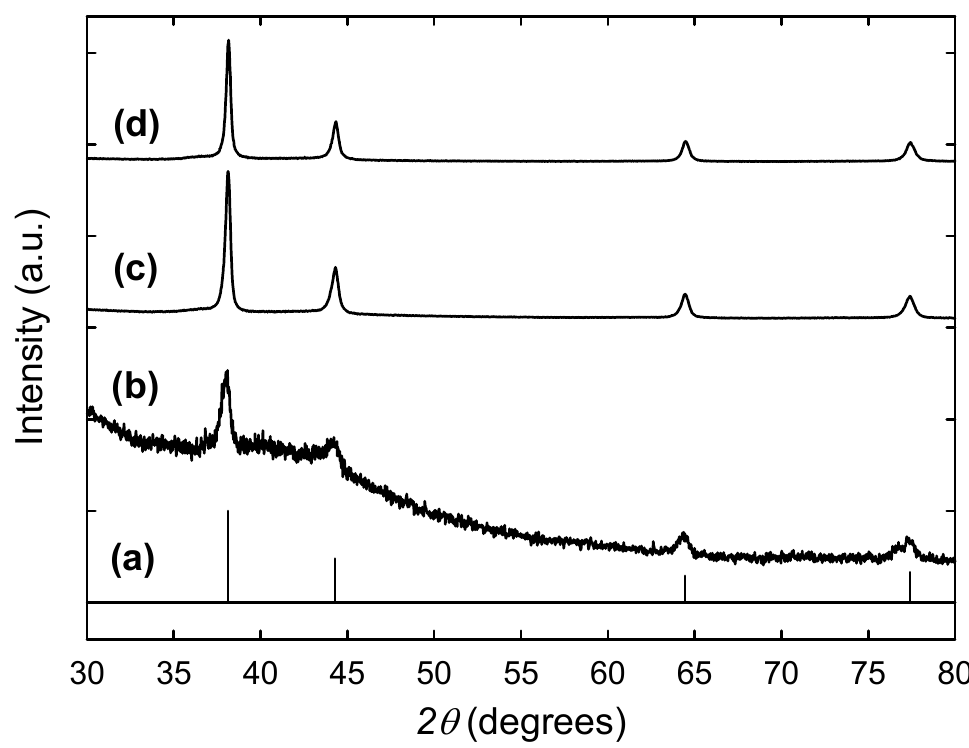
Figure 2. X-ray diffraction patterns of the Ag NPs embedded in resin beads prepared with increasing AgNO 3 concentrations of 1 mM ( b ), 10 mM ( c ), and 50 mM ( d ) and compared with that of bulk fcc silver in the JCPDS database ( a ).